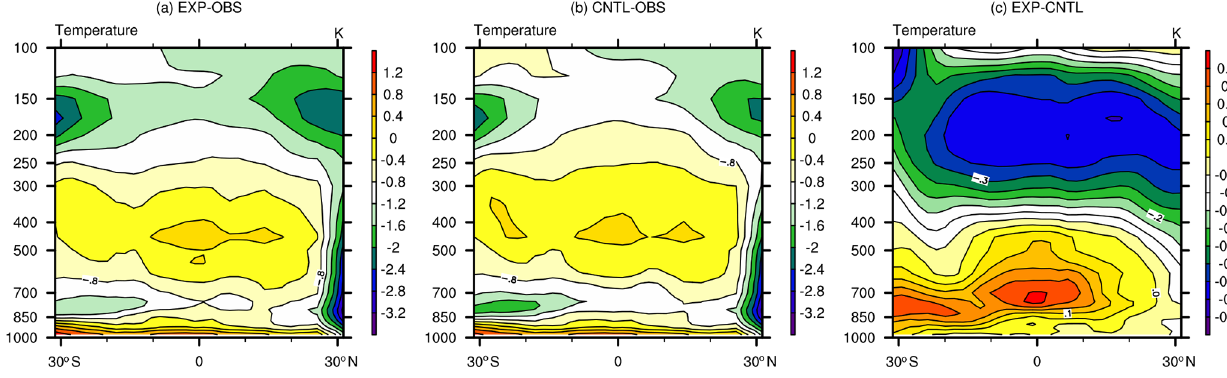
Figure 8. Pressure–latitude distributions of temperature of (a) EXP–OBS, (b) CNTL–OBS, and (c)